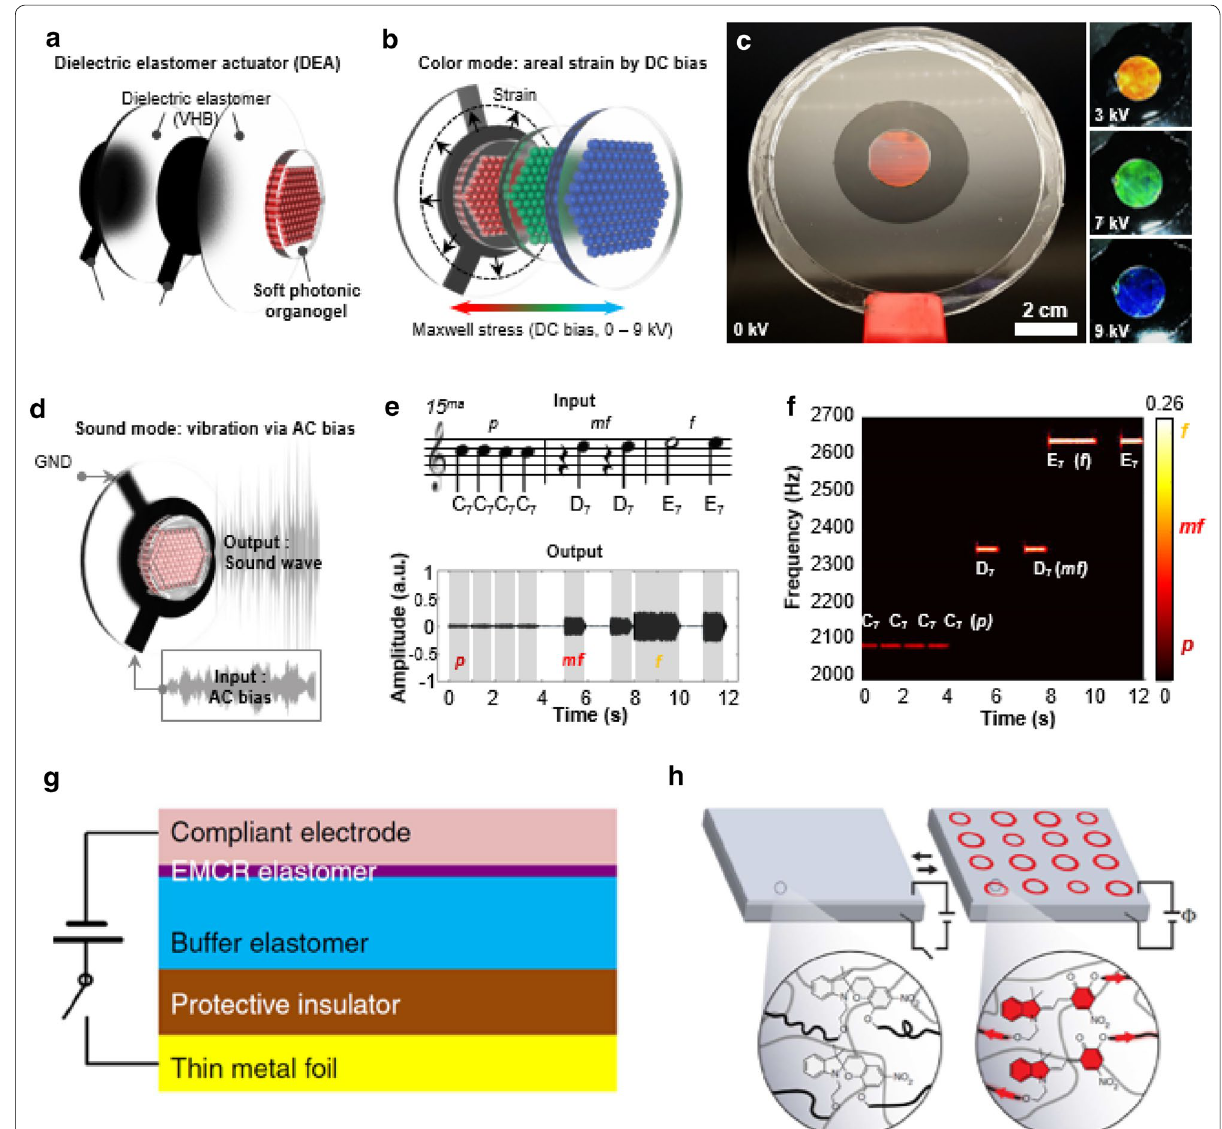
Fig. 11 Electromechanically driven mechanochromic polymers. a Structure of electromechanical photonic crystals using dielectric elastomer actuator. b Photonic organogel is electrically operated with Maxwell stress induced by a DC bias, which results in areal expansion of the photonic gel. c Digital images show various colors from red to blue. d The electromechanical photonic device can generate sound in the audible frequency regime. e Piano notes to be programmed as an input signal to the device and recorded sound waves from a microphone. f A short‑time Fourier transformation data, allowing for visualization of the frequencies over time. g Schematic structures for electro‑mechano‑chemically responsive(EMCR) color change displays. h Mechanism for the device using mechanochromic spiropyran materials. The applied voltages induce a large deformation in the elastomer, which causes ring open reaction of spiropyran resulting in color change (Figure reproduced from a – f [82], Copyright 2018, WILEY‑VCH Verlag GmbH & Co. KGaA, Weinheim; g , h [83], Copyright 2014, Springer